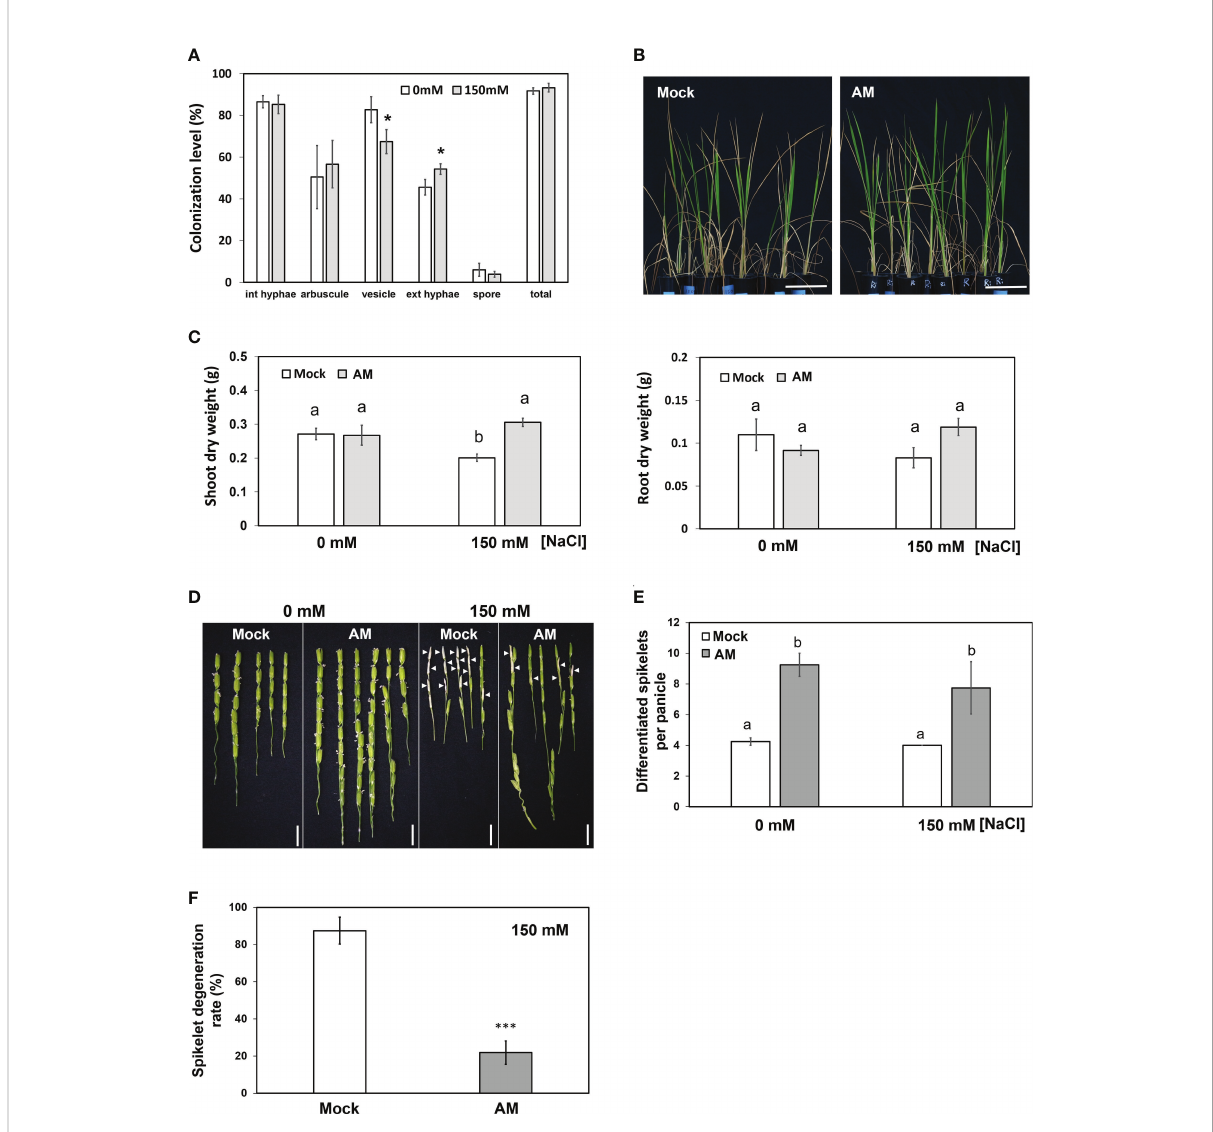
FIGURE 1 Physiological and agronomic traits of mock and mycorrhizal plants under salt stress. (A) Fungal colonization levels expressed as a percentage of colonized roots. (B) Phenotype of rice plants under salt stress. (C) Dry weight of shoots and roots. (D) Spikelet phenotype. Arrowheads indicate the typical salt-injured spikelets. (E) Comparison of spikelet number per panicle in mock and mycorrhizal plants. (F) Spikelet degeneration rate of mock and mycorrhizal plants under salt stress. The spikelet degeneration rate was de fi ned as the degenerated spikelet number divided by the total number of spikelets per panicle. Rice plants were grown without (mock) or with the AM fungus R. irregularis (AM) for 5 weeks and then treated with normal (0 mM NaCl) or salt solution (150 mM NaCl) for 3 weeks. Standard error is derived from 3-7 biological replicates. One plant was considered one biological replicate in (C-F) , and two plants were considered one biological replicate in (A) . Different letters represent signi fi cant differences at p < 0.05 (two-way ANOVA followed by a least signi fi cant differences post hoc test). * p < 0.05, *** p < 0.001 for Student ’ s t test. Scale bar = 10 cm in (B) and 1 cm in (D)